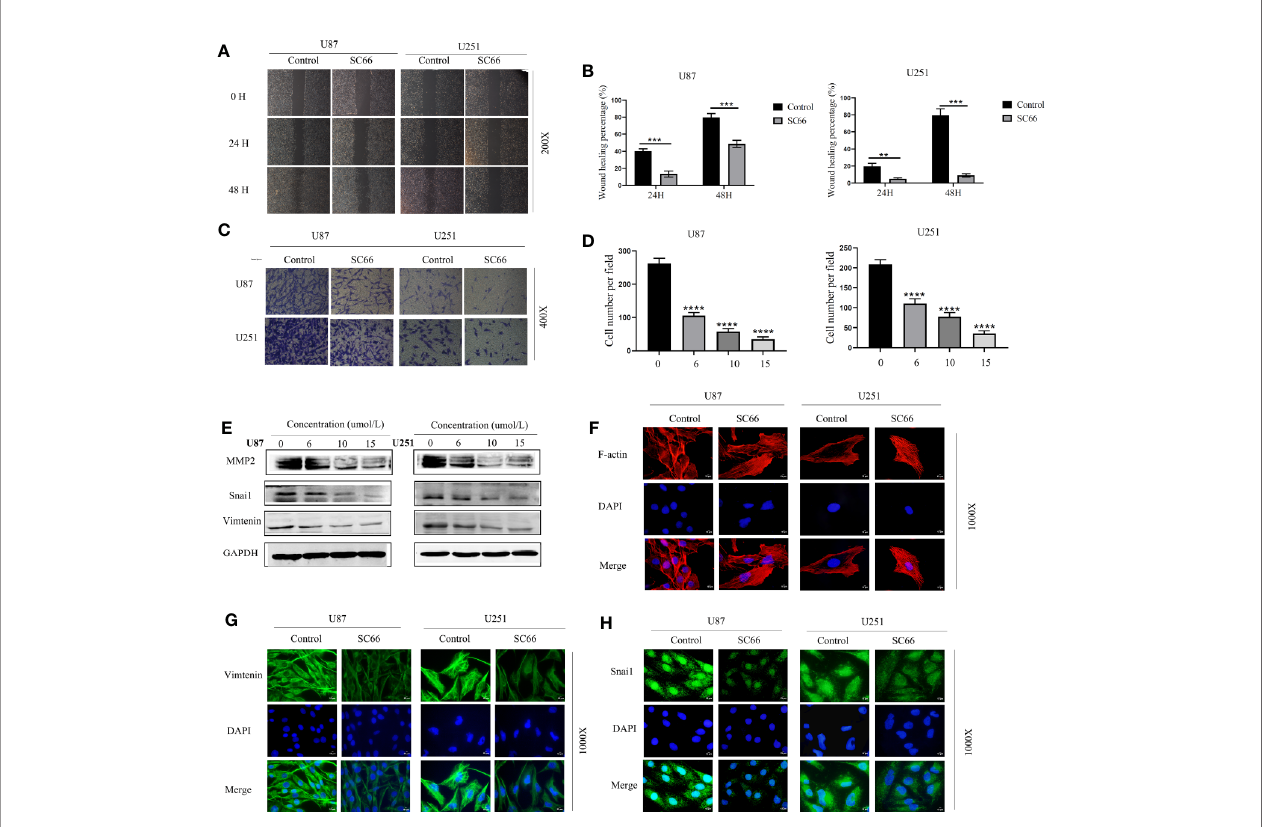
FIGURE 2 | SC66 suppressed the metastatic biological functions of GBM cells in vitro . (A, B) Wound healing was demonstrated that SC66 suppressed the migration of U87 and U251 cells. (C, D) Tanswell assay showed that SC66 inhibited the invasion of U87 and U251 cells. (E) The expression of MMP2, Vimentin, and Snai1 after SC66 treatment. (G, H) Representative fl uorescent images of Vimentin and Snai1 in U87 and U251 cells. (F) Cells were stained of F-actin with Phalloidin. For at least 3 independent experiments. **P < 0.01, ***P < 0.001, ****P <